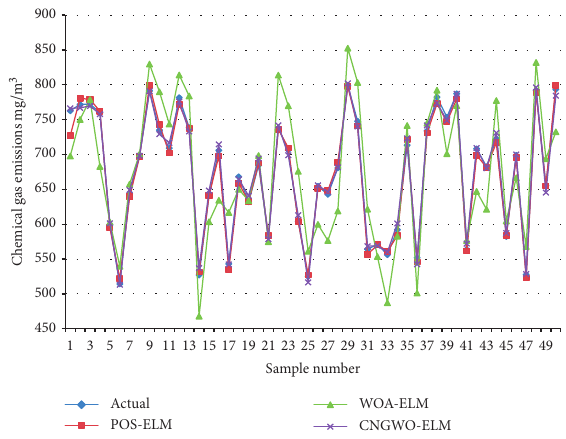
Figure 4: Comparison of CNGWO-ELM with other algorithms. Table 4: Precision analysis of forecast results of 3 algorithms for testing set. Sample